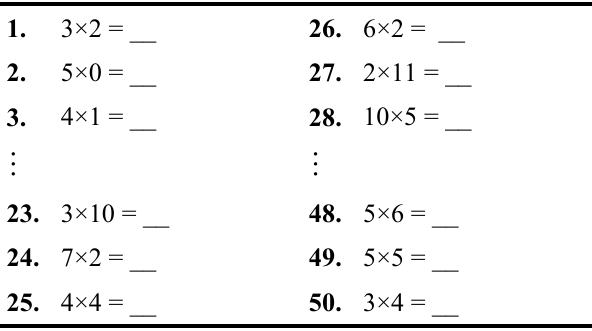
Figure 4 : An abbreviated excerpt of commercially available multiplication